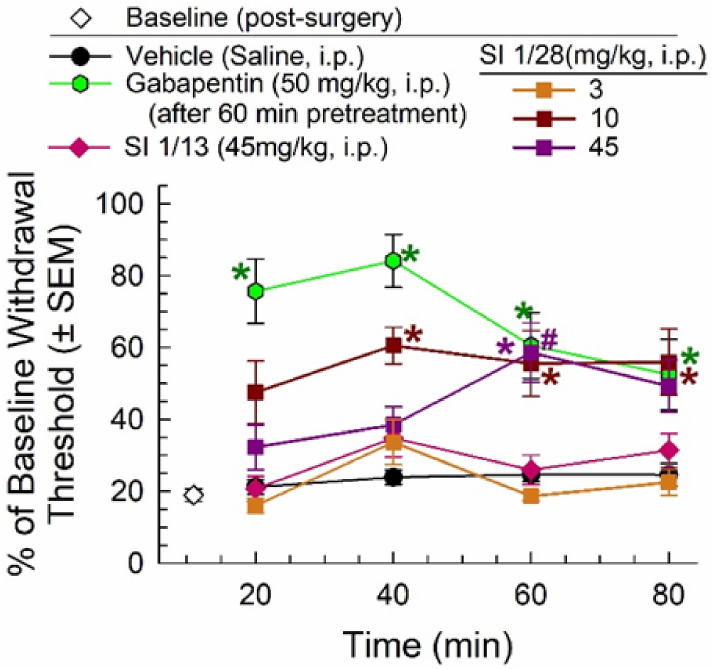
Figure 3. Dose- and time-dependent anti-allodynic activity of SI 1/28 (squares) in the mouse CCI assay of neuropathic pain. Mechanical allodynia produced from sciatic nerve ligation was reduced from 40–80 min (10 mg/kg, i.p., red squares) and 60–80 min (45 mg/kg, i.p.; purple squares), similar to the effect of the positive control, gabapentin (green hexagon). SI 1/28 (45 mg/kg, i.p.; purple squares) was significantly increased compared to the parent compound, SI 1/13 (pink